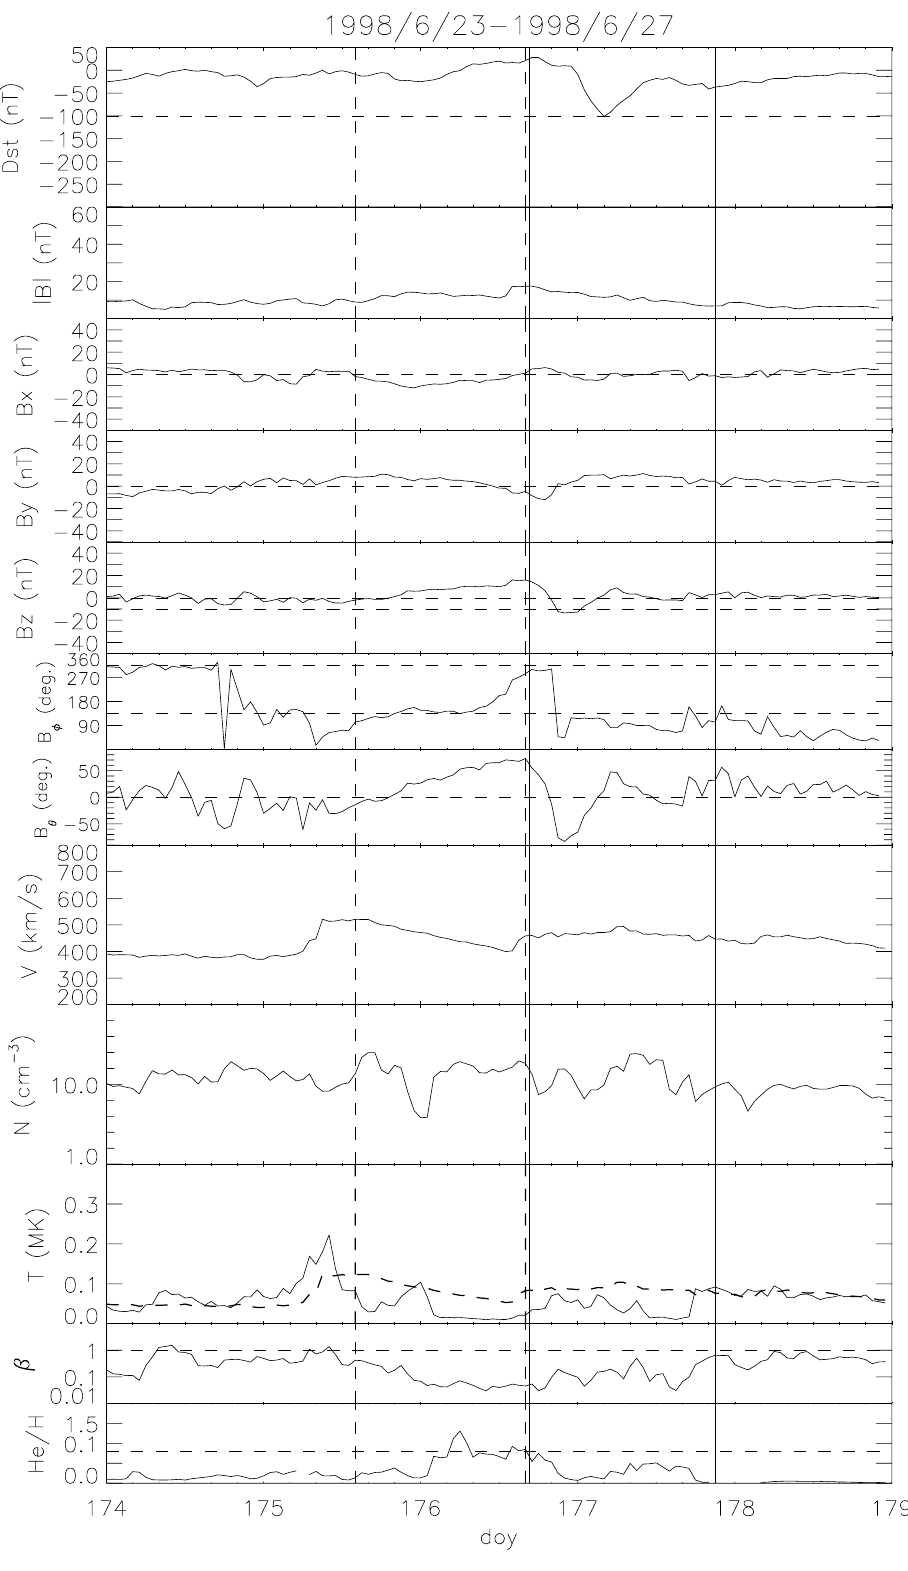
Fig. 6. D st index and solar wind parameters of storm no. 4. Two vertical solid lines show the duration of the geomagnetic storm and two vertical dash lines show the duration of a magnetic flux